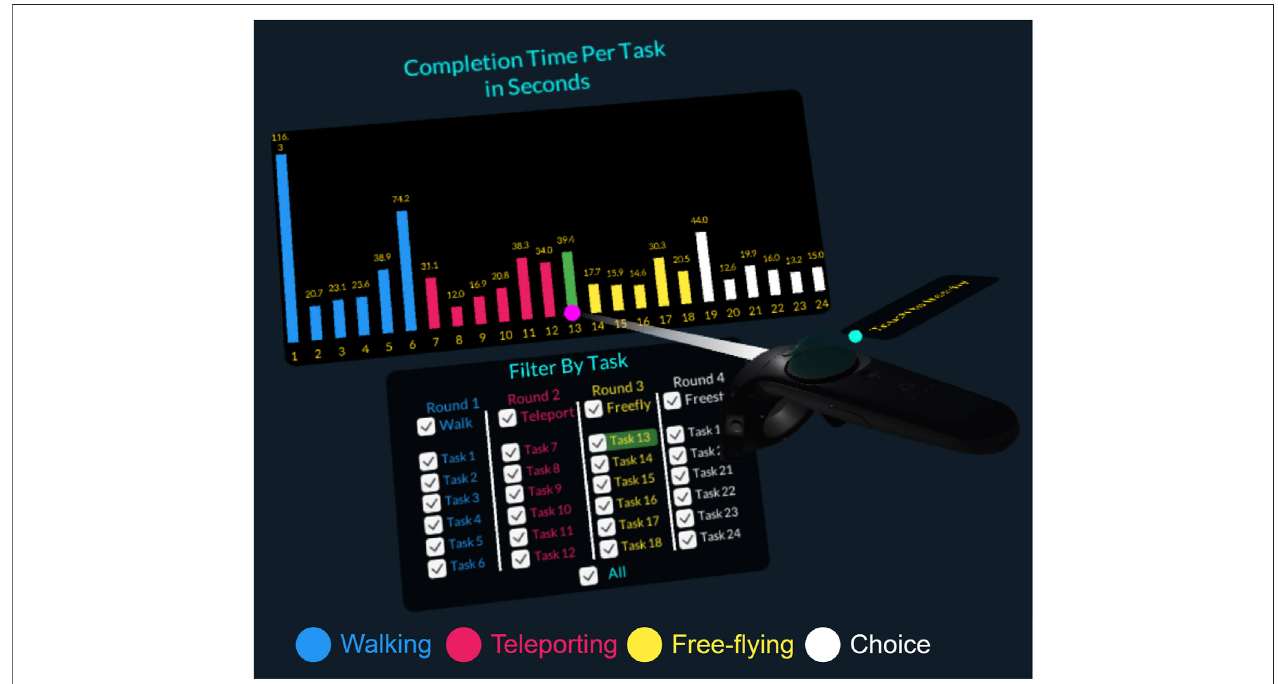
FIGURE8| Theinteractivelegendandbargraphvisualizationforthecompletiontimesofall24tasksinVRTrial1.Notethelinkandbrushfunctionalityastheuseris hovering over the bar for task #13.